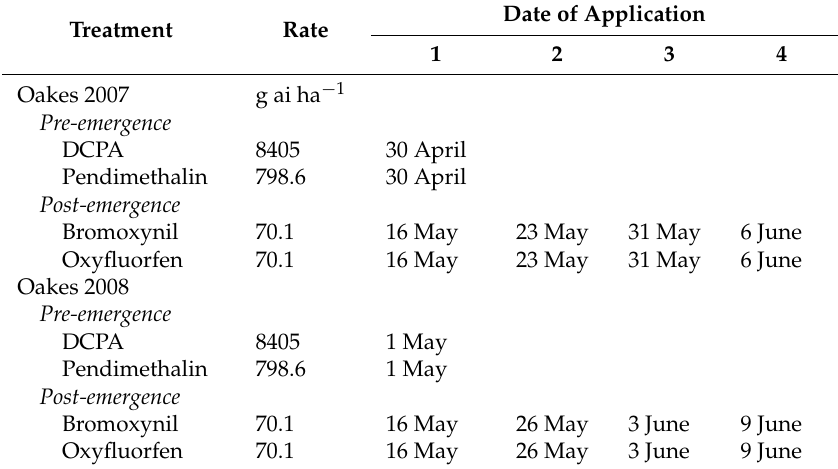
Table 1. Pre- and post-emergence herbicide application rates and timings at Oakes, ND, USA in 2007 and